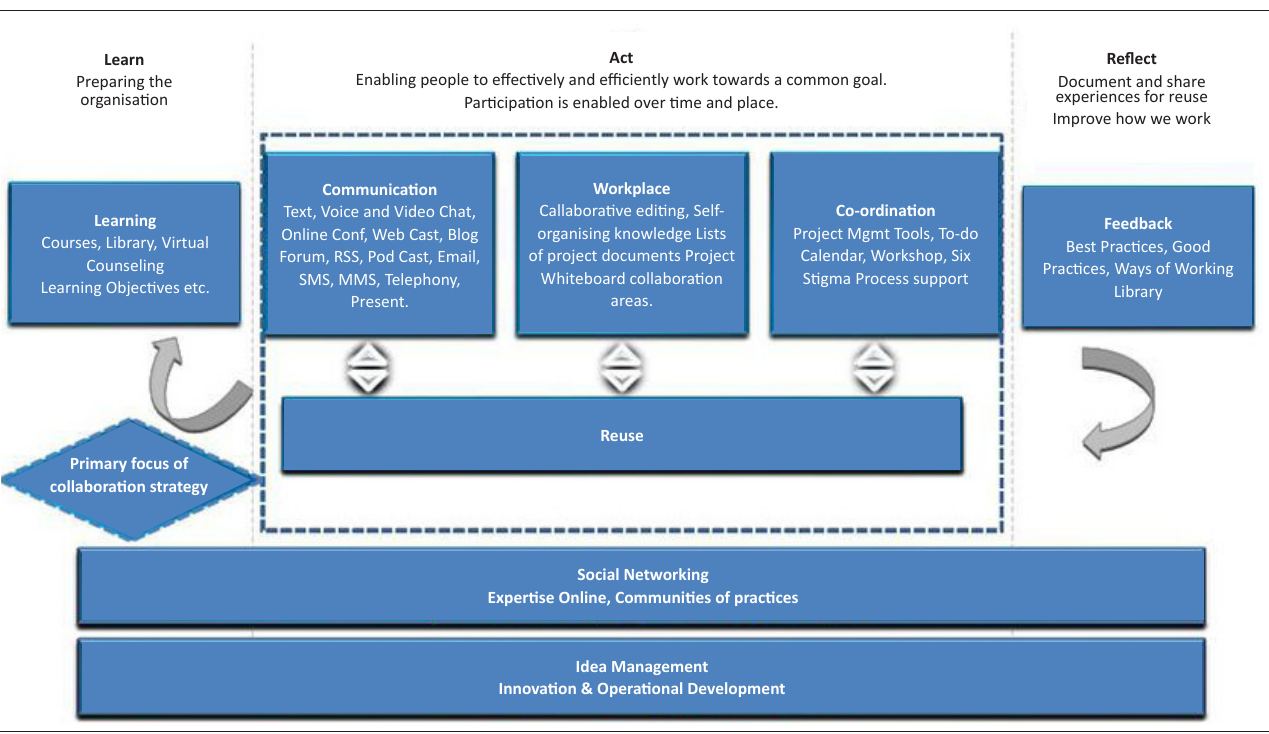
FIGURE 6: The MultiChoice Collaboration